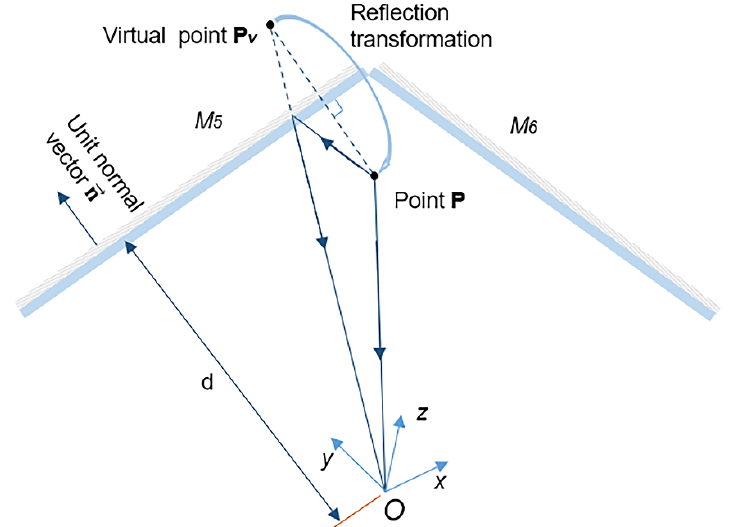
Figure 4. Schematic diagram showing the reflection transformation from virtual point P v to its corresponding real point P .